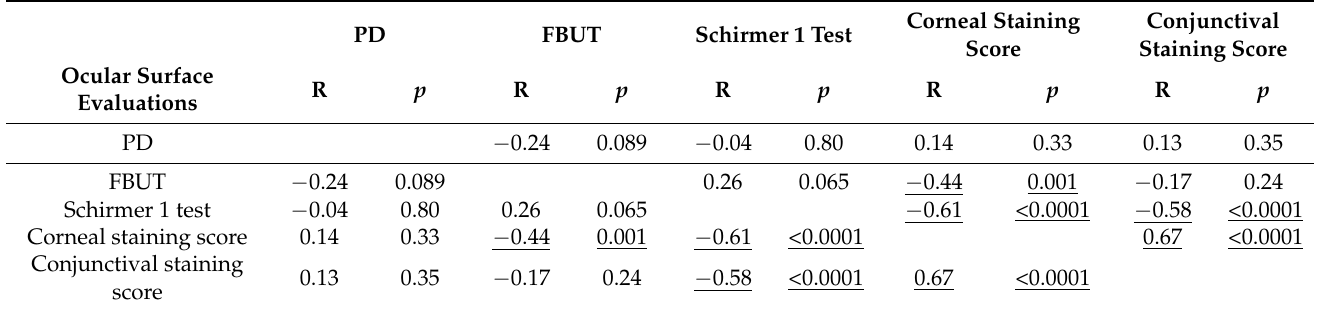
Table 3. Correlation between PD and Ocular Surface Evaluations. FBUT